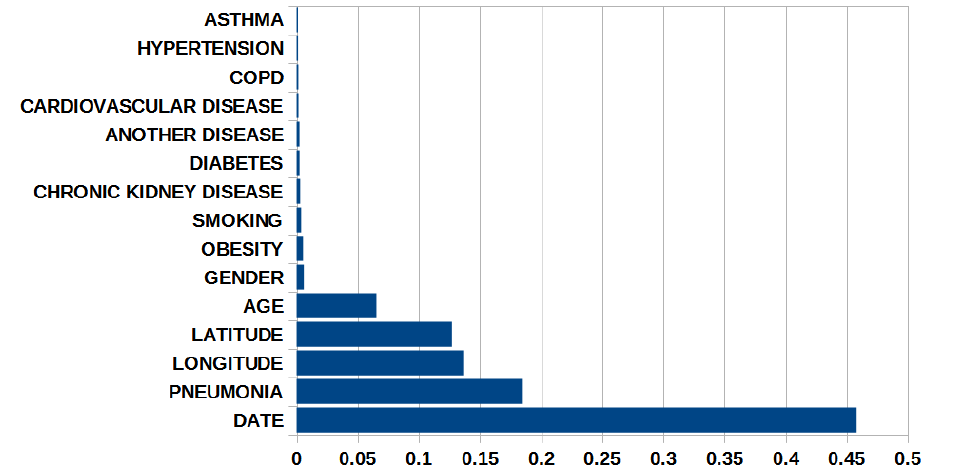
Figure 9. Importance of explanatory variables in